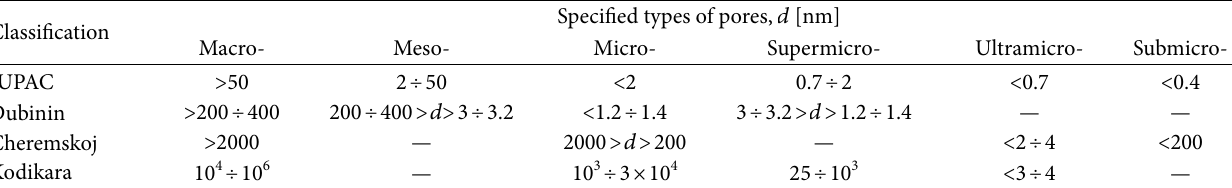
Figure 3: Cross section picture before (a) and after (b) binarization processing. Table 4: Summary of the most frequently used pore size classifications